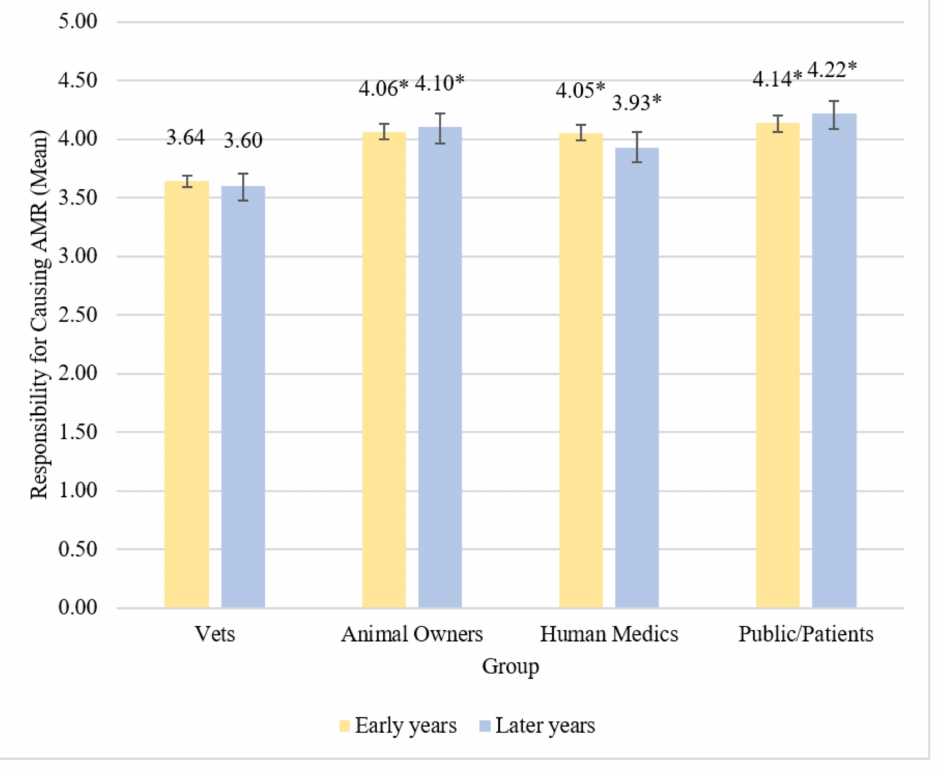
Figure 2. Mean beliefs about responsibility for causing ABR by group among early and later years students. Vets designated as reference group. * denotes difference from reference group at p < 0.001. Error bars represent 95% bias-corrected and accelerated bootstrap confidence